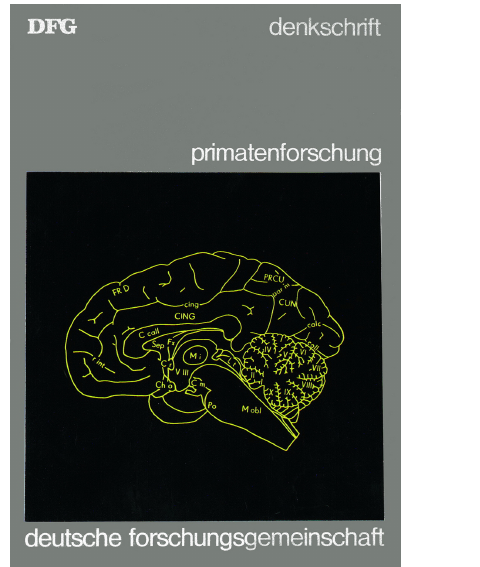
Figure 5. The cover of the DFG memorandum on primate research in Germany, written by Hans-Jürg Kuhn in 1970 (picture from DPZ